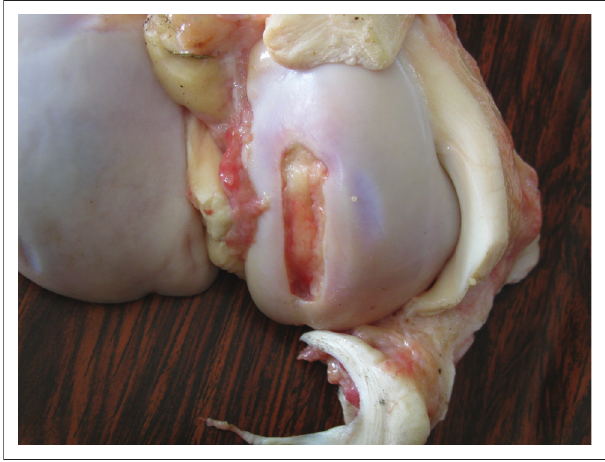
Source : Photo taken by Leon Prozesky FIGURE 2: Irregular crater in the right femur condyle.